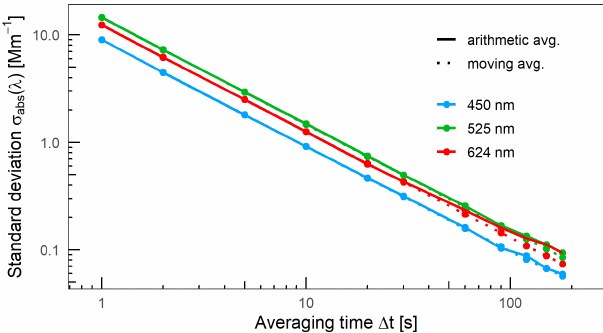
Figure 4. Standard deviation of σ abs (λ) in the dependency of the averaging time ( (cid:49)t ) measured by STAP during sampling of particle- free air analyzed with arithmetic and centered moving